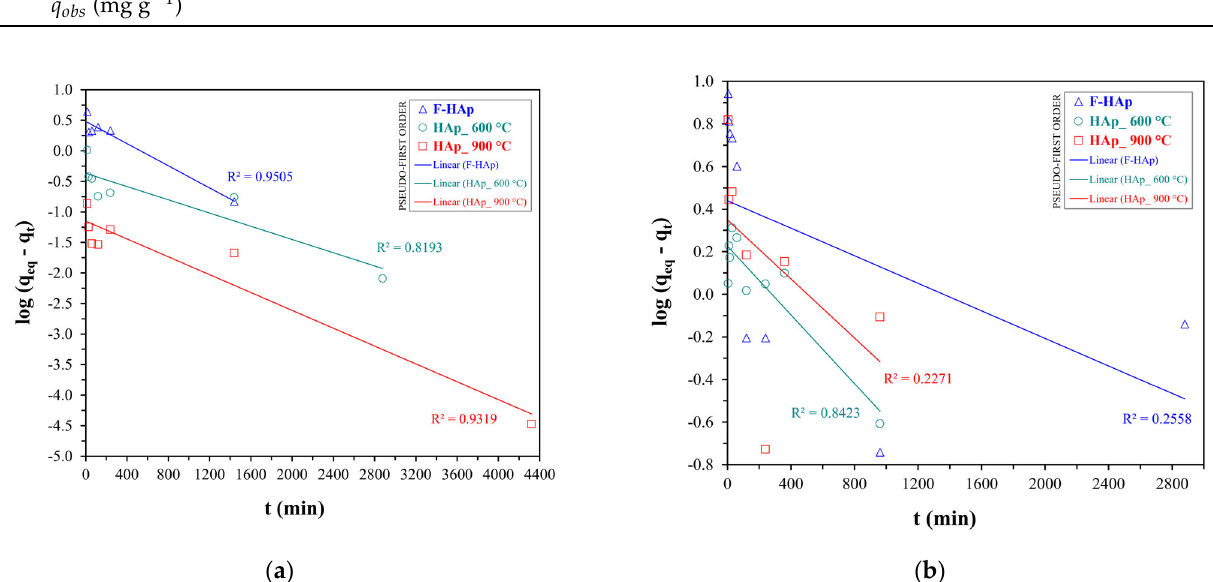
Figure 7. Linear fitting plots of pseudo ‐ first order kinetic model for ( a ) atrazine and ( b ) cobalt ad ‐ sorption.